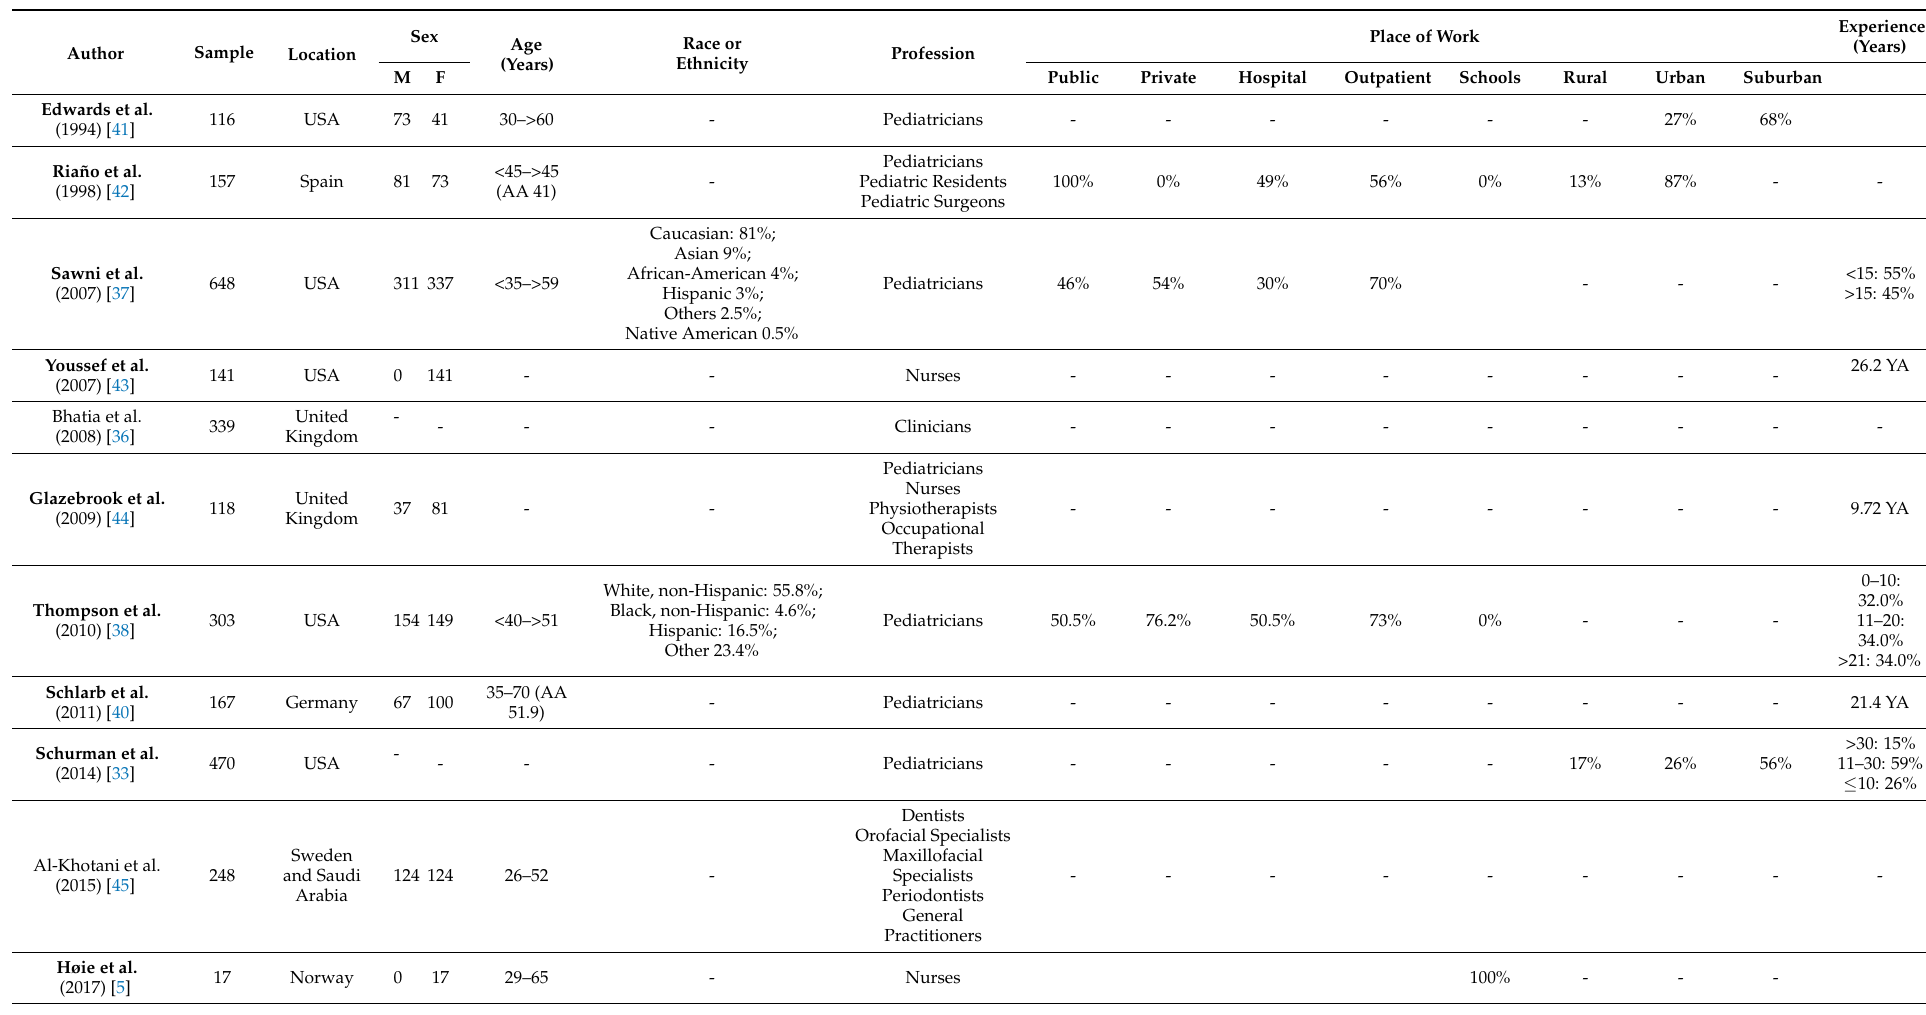
Table 1. Sociodemographic characteristics of the health professionals included in the clinical studies of the systematic